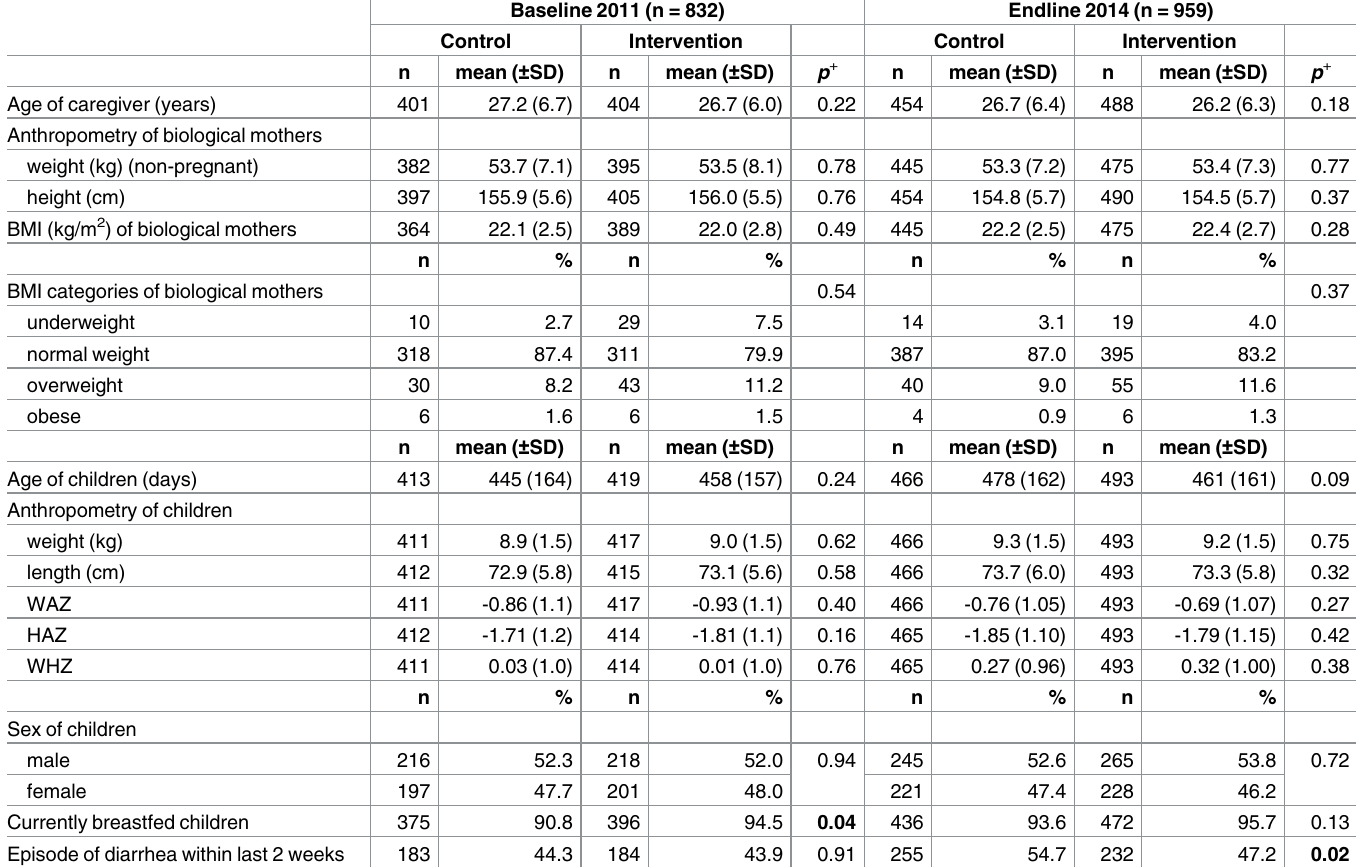
Table 3. Characteristics of primary caregivers and children at baseline and